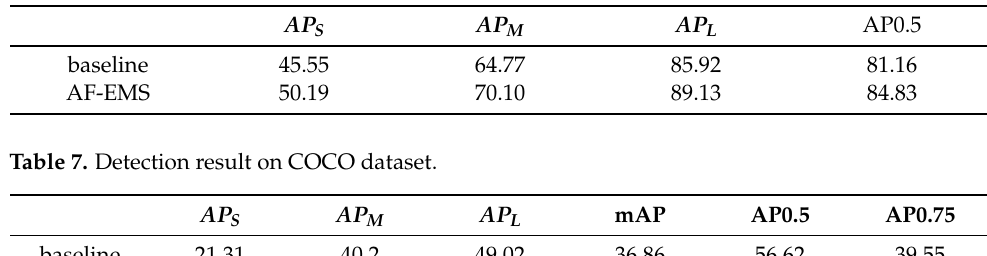
Table 6. Detection result on VOC dataset.